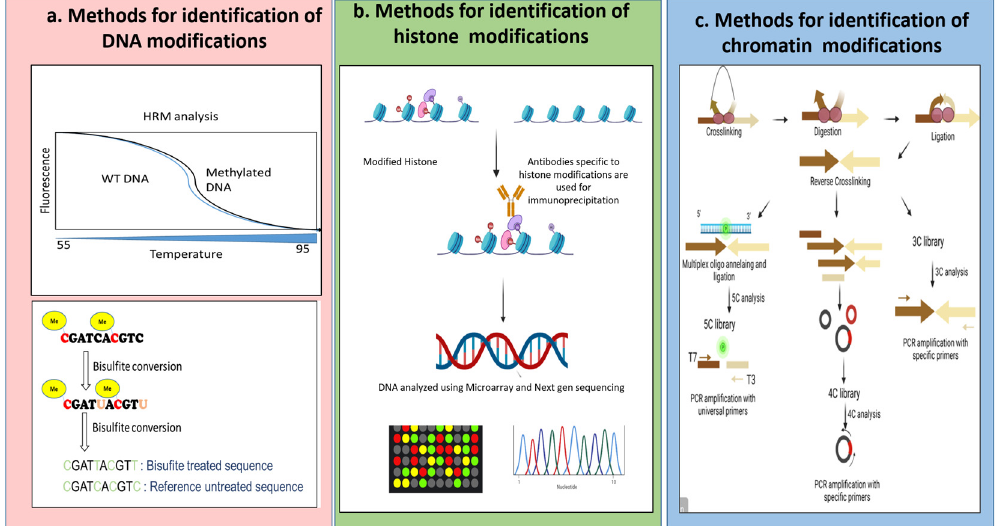
Figure 1. Schematic representation of some of the methods to identify epigenetic modifications. ( a ) Describes the methods for identification where DNA modification occurs. It can be analyzed via HRM analysis or the most prevalent technique of Bisulphite sequencing. ( b ) Describes the methods for identification where a histone modification occurs. It can be performed using methods of im- munoprecipitation followed by sequencing and microarray. ( c ) Describes the methods for identifi- cation where chromatin modification occurs. It can be done by a series of steps of crosslinking, di- gestion, and ligation followed by the generation of libraries and sequencing using universal or spe- cific primers following the 3C, 4C and 5C techniques. Image developed using Biorender.com (ac- cessed on 7 September 2022).